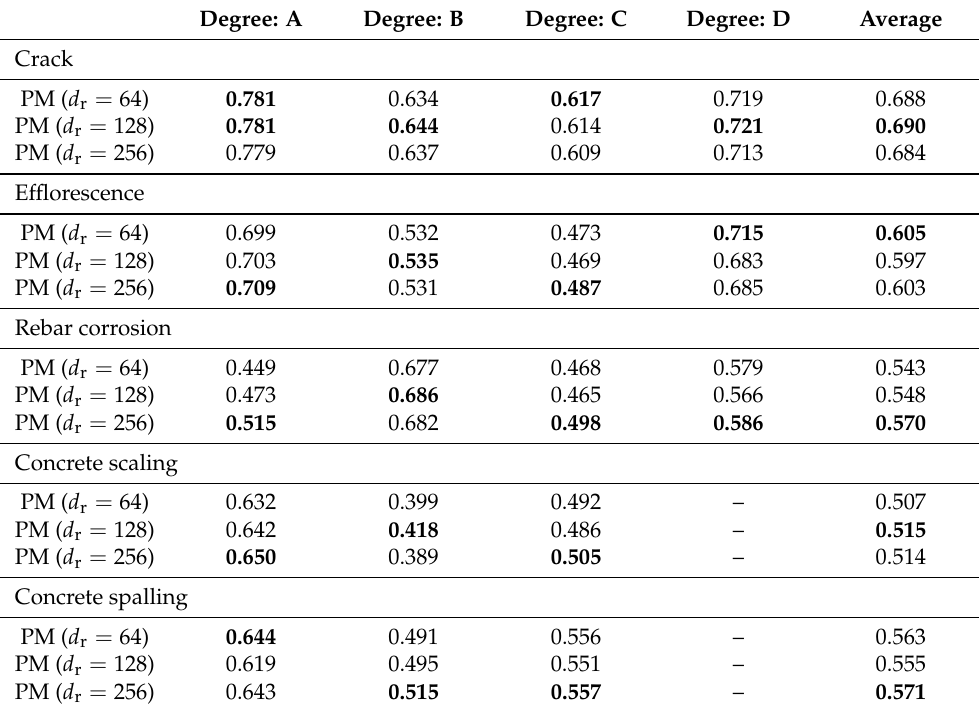
Table 13. F1-scores of PM using SimCLR parameters corresponding to multiple dimensions of the feature representation. The best scores for each degree and the average are presented in